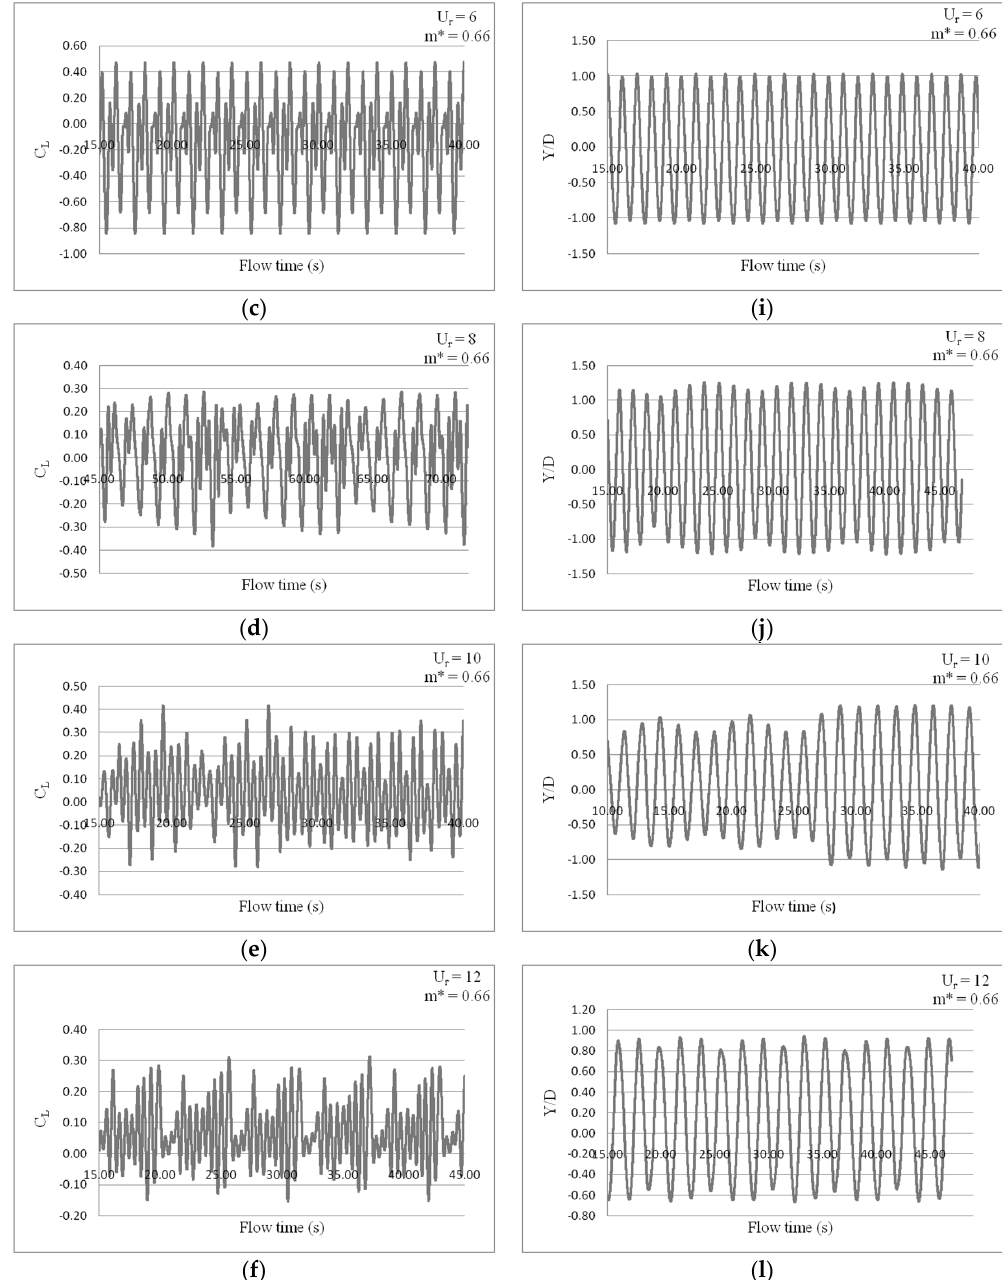
Figure 4. Time histories of hydrodynamic and structural response parameters at m* = 0.66: ( a ) C L for U r = 4; ( b ) C L for U r = 5; ( c ) C L for U r = 6; ( d ) C L for U r = 8; ( e ) C L for U r = 10; ( f ) C L for U r = 12; ( g ) Y/D for U r = 4; ( h ) Y/D for U r = 5; ( i ) Y/D for U r = 6; ( j ) Y/D for U r = 8; ( k ) Y/D for U r = 10; ( l ) Y/D for U r = 12.